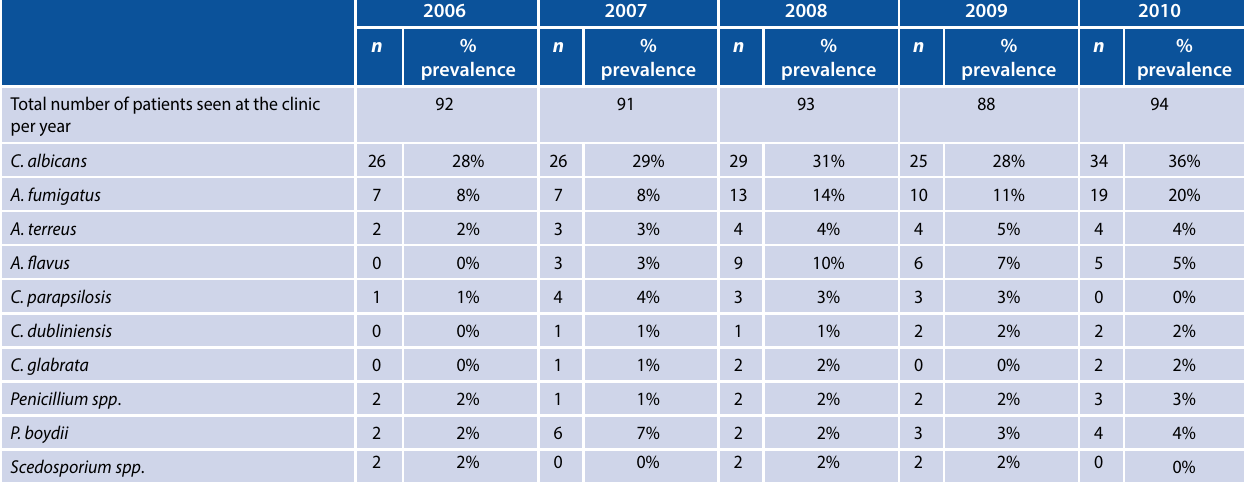
Table 3: Changes to antimicrobial susceptibility among P. aeruginosa isolates Table 4: Yearly prevalence of the most commonly isolated yeast and mould species between 2006 and 2010 Antibiotic No. Susceptible/ total number